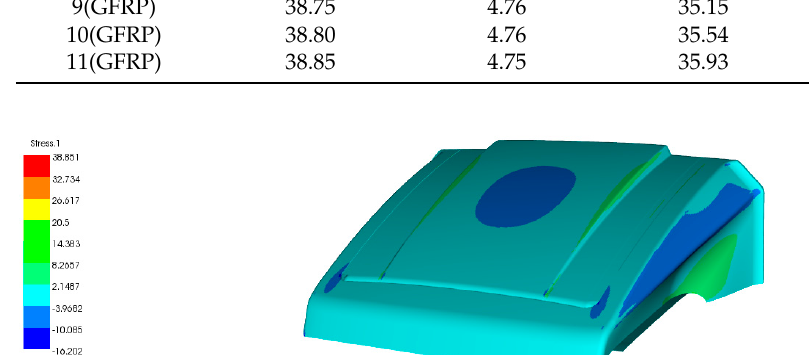
Figure 10. Finite element model of faring.